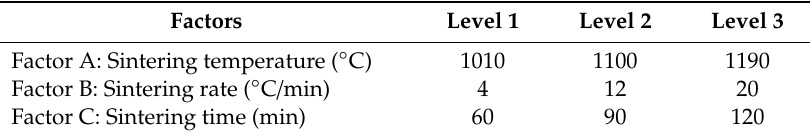
Table 8. Experimental factors with each level [14].